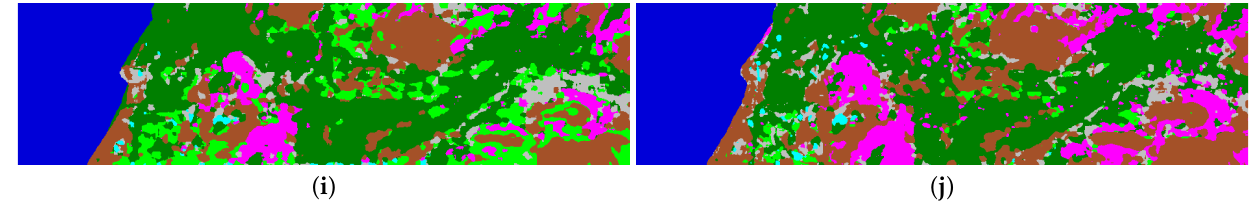
Figure 16. Classification maps for the HyRANK dataset. ( a ) SVM (OA = 51.2%). ( b ) EMP (OA = 45.9%). ( c ) DenseNet (OA = 49.7%). ( d ) DPRN (OA = 49.0%). ( e ) FDMFN (OA = 52.2%). ( f ) MSRN (OA = 51.7%). ( g ) LWRN (OA = 51.8%). ( h ) SSSERN (OA = 48.9%). ( i ) DRN (OA = 52.1%). ( j ) Proposed DRIN (OA = 54.4%).